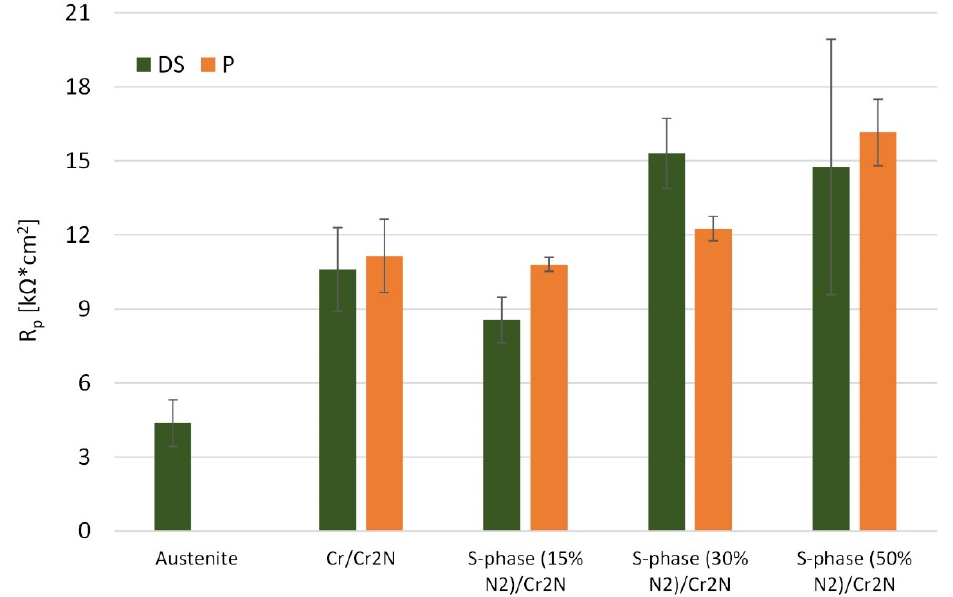
Figure 8. The influence of interlayer type on the polarization resistance R p for investigated composite coatings.